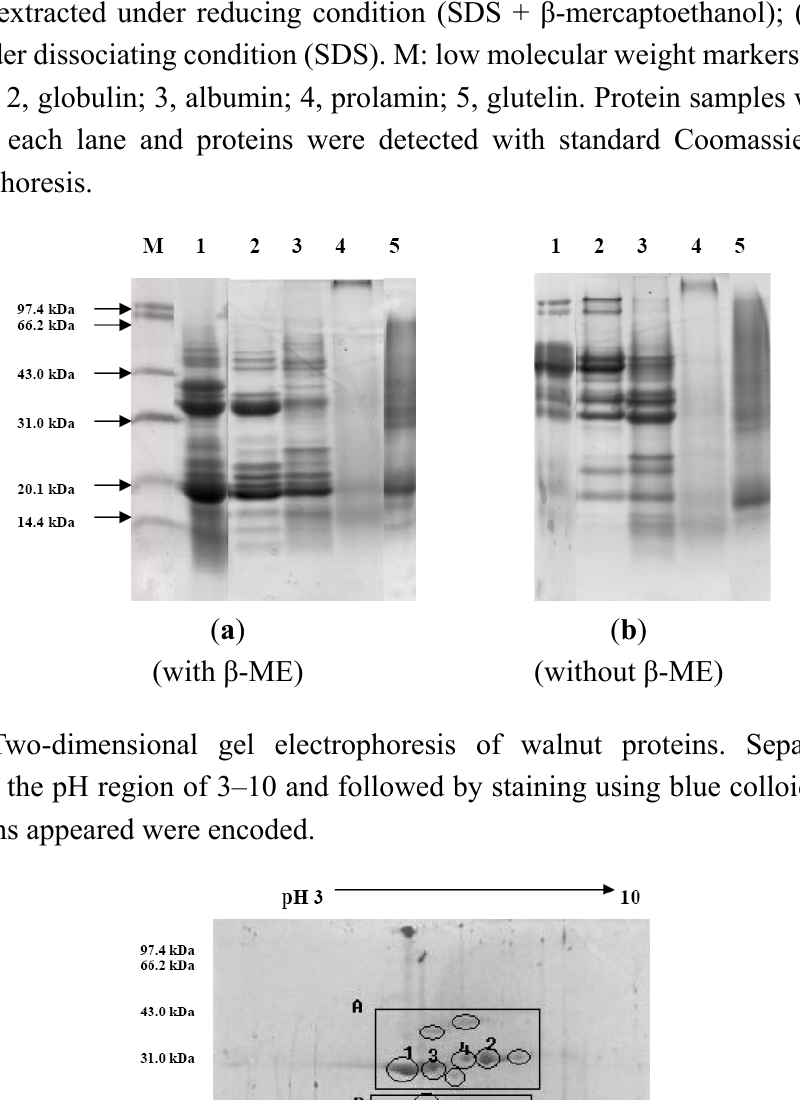
Figure 2. The SDS-PAGE profiles of walnut proteins and four protein fractions.